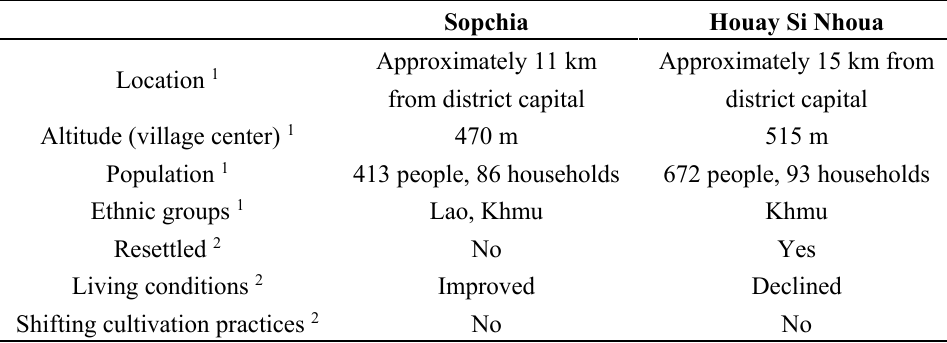
Table 1. Main characteristics of the villages studied.